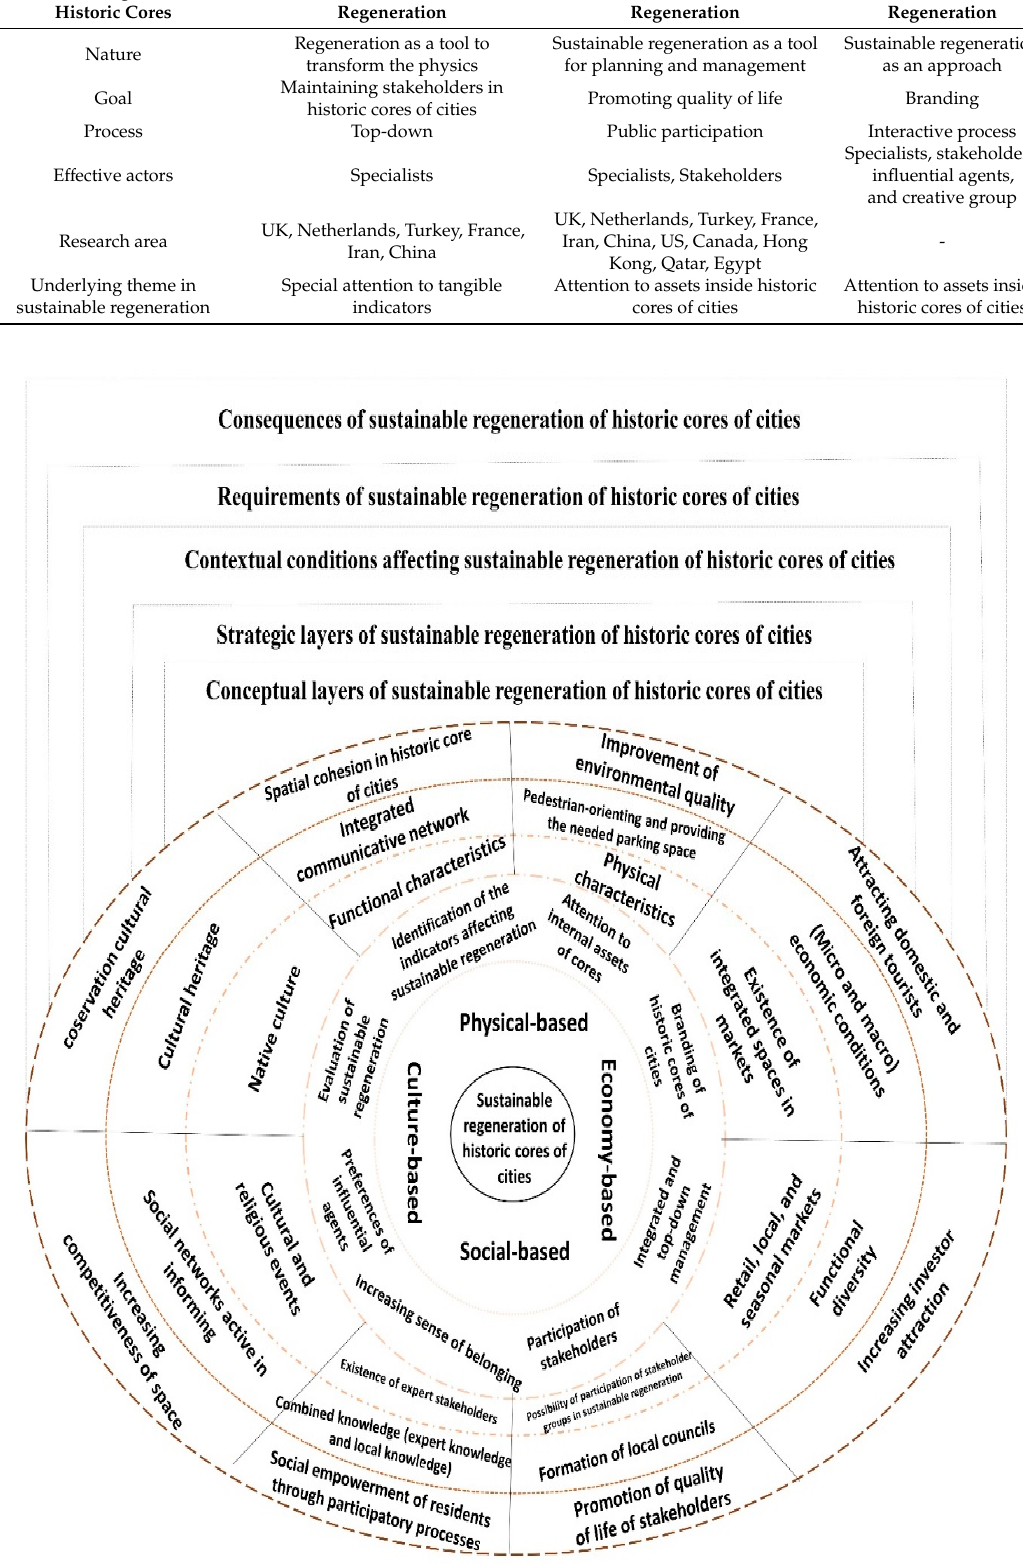
Figure 9. Conceptual model of sustainable regeneration of the historic cores of cities.